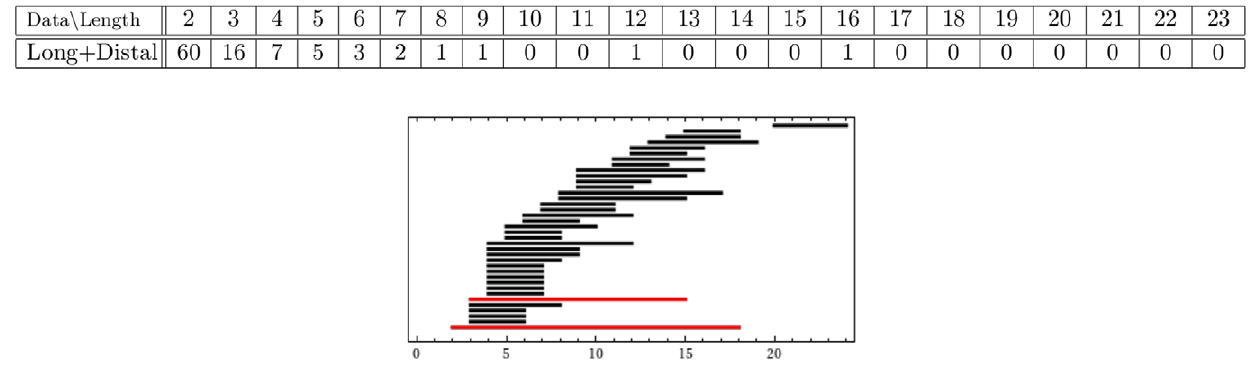
Figure 7. b 1 -persistence intervals (only lifespans w 2 are displayed) for the combined long + distal data set.